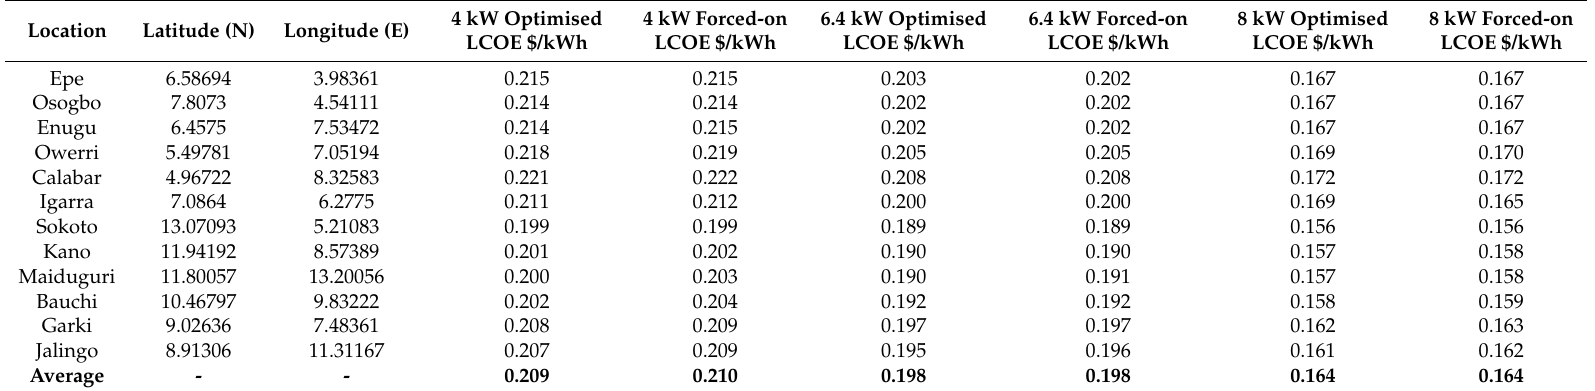
Table 4. Lcoe ($/kWh) for the different loads.